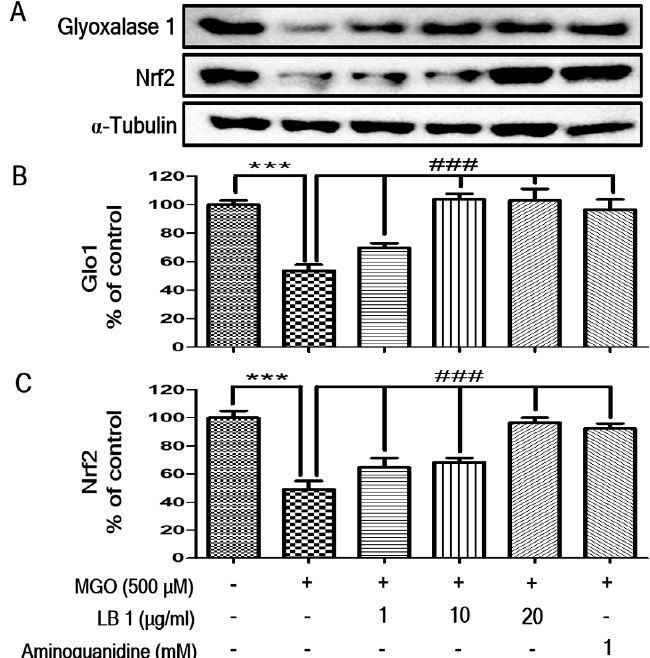
Figure 2. The effect of LB on Glo1 and Nrf2 protein expression. ( A ) Images showing the expression of Glo1 and Nrf2 proteins as measured by western blot analysis; and the relative band intensities of ( B ) Glo1 and ( C ) Nrf2. The bar values represent the mean ± SEM (## p < 0.01 and ### p < 0.001 vs. MGO treatment, and ** p < 0.01 vs. the control).